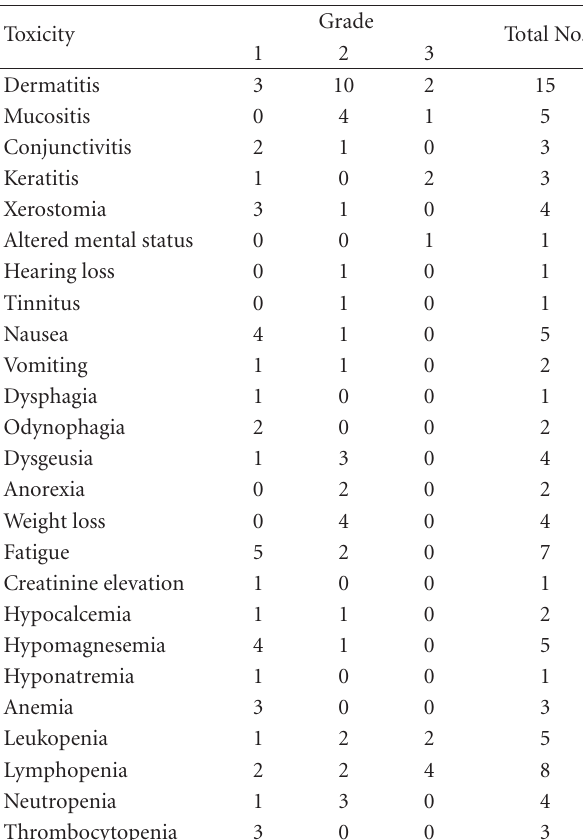
Table 2: Overall toxicity in chemoradiotherapy patients.